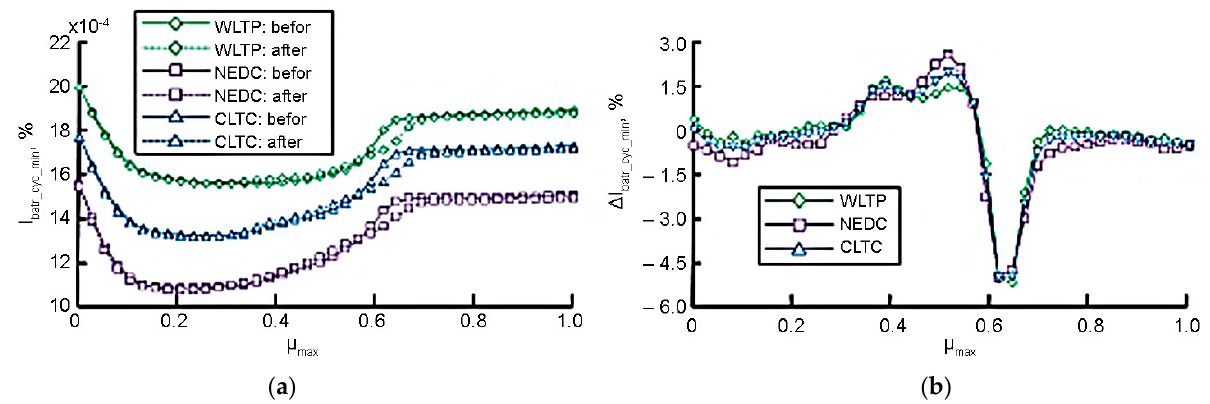
Figure 9. Test results for three driving cycles before optimization after optimization: ( a ) for good tire grip, ( b ) for low tire grip.